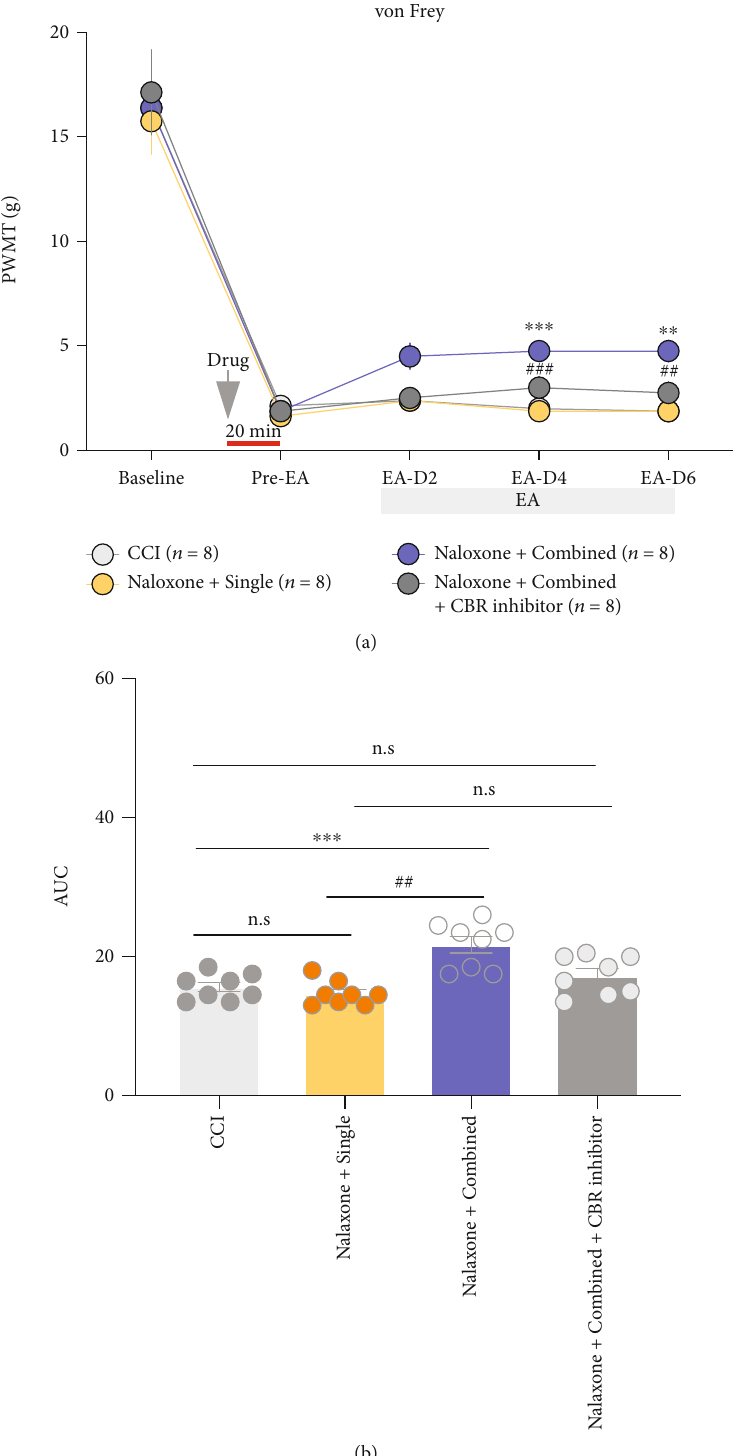
Figure 6: Intrathecal injection of cannabinoid receptor inhibitors blocked the analgesic e ff ect of combined-acupoint EA. (a) Schematic and timeline showing pain behavior tests. All rats were injected with nonselective opioid receptor inhibitor naloxone. Naloxone completely inhibited the antinociceptive e ff ect of single-acupoint EA but just partially reversed the analgesia induced by combined-acupoint EA. Coadministration of naloxone and CBR inhibitors eliminated the analgesic e ff ect of combined-acupoint EA; two-way ANOVA followed by Bonferroni ’ s multiple comparisons test. (b) Area under the curve of graph a (from “ BL ” to D6). Student ’ s unpaired t -test. All data are mean ± SEM , ∗ P < 0 : 05 , ∗∗ P < 0 : 01 , ∗∗ P < 0 : 01 vs. CCI; ## P < 0 : 01 , ### P < 0 : 001 vs. naloxone + single; n.s.: not signi fi cant; N = 8 in each group. CCI: chronic constriction injury; EA: electroacupuncture; PWMT: paw withdrawal mechanical threshold; CBR: cannabinoid